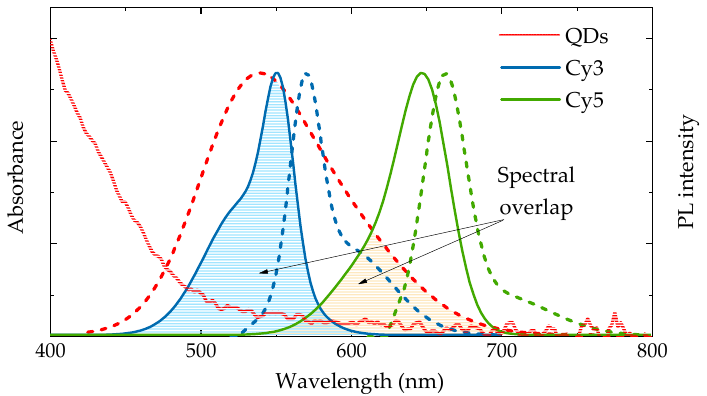
Figure 2. Absorption (red solid line) and photoluminescence (PL) (red dotted line) spectra of aqueous solutions of AgInS 2 / ZnS QDs as well as the normalized absorption (blue and green solid lines) and PL (blue and green dotted lines) spectra of Cy3 and Cy5 dyes, respectively. PL excitation: QDs–405 nm, Cy3–520 nm and Cy5–620 nm, respectively.